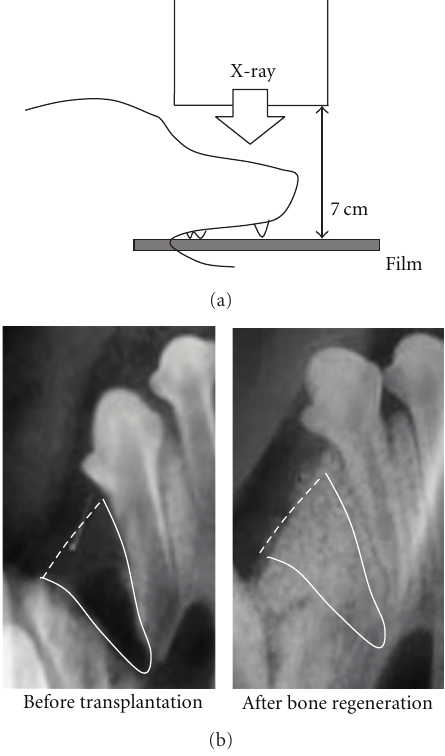
Figure 1: X-ray examination of bone regeneration (a) Schema of standardized occlusal X-ray examination. A film was held parallel to the upper dentition of a beagle dog, and X-rays were irradiated vertically to the film at 250 mV. The angle and distance between X- ray bulb and film were standardized using a locator. (b) The radio- opacity without signals of CAP particles in the artificial jaw cleft area was measured on standardized occlusal X-ray